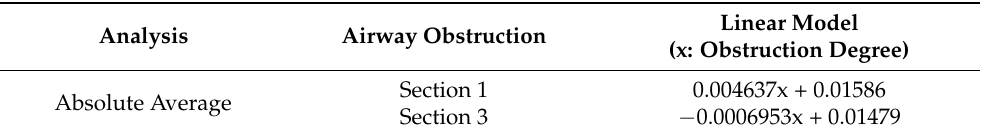
Figure 8. Graph of absolute average analysis result for Phase C of flow. Table 2. Linear model results of absolute average analysis for degrees of obstruction in accordance with location of obstruction.